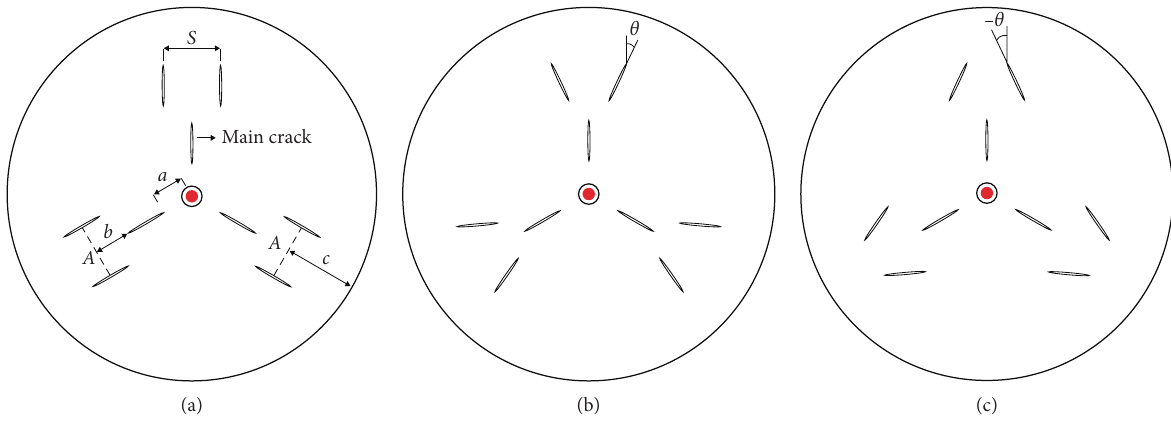
Figure 2: Three types of circular specimens and the dimensions. (a) Parallel. (b) θ > 0 ° . (c) θ < 0 ° .